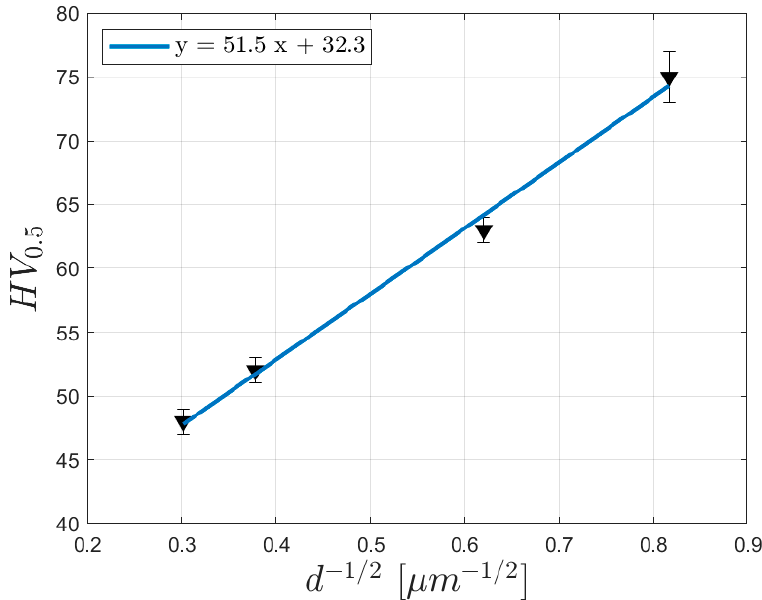
Figure 10. Hall–Petch plot showing the dependence of the microhardness on (grain size) − 1 / 2 . (Grain size was calculated from the average density of grain boundaries in the case of bimodal grain size distribution.)